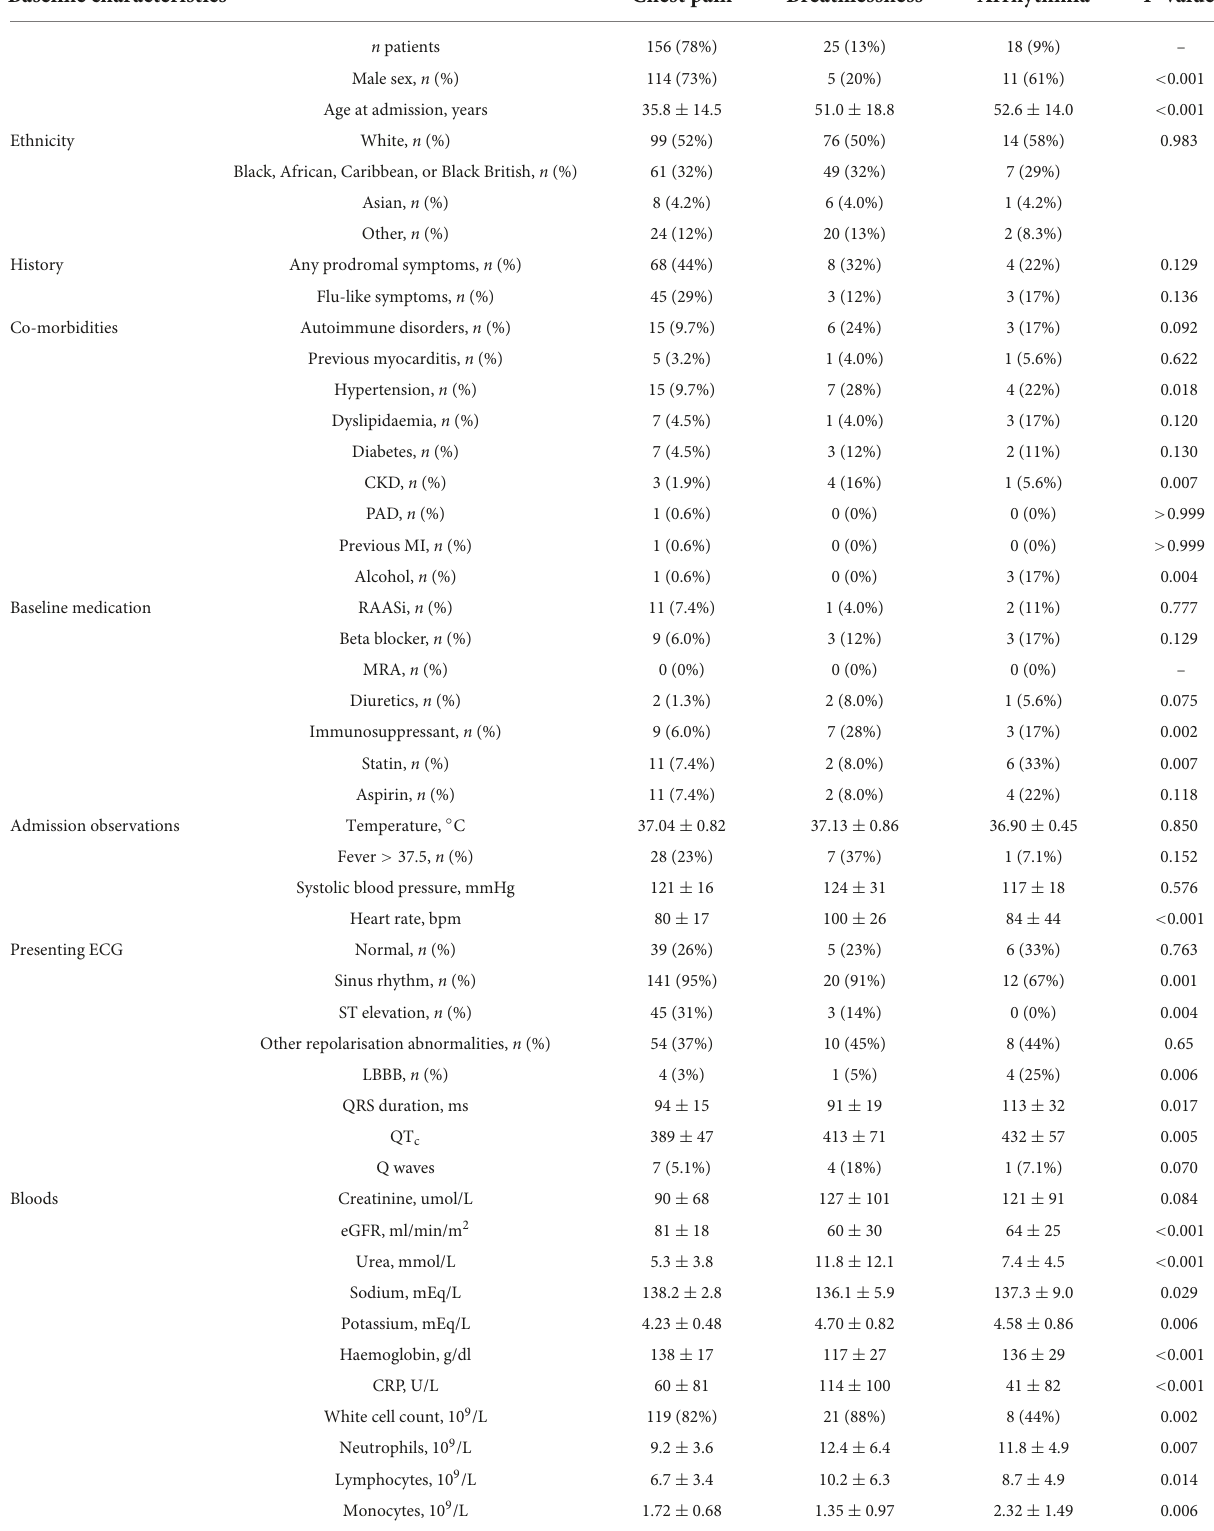
TABLE 2 Characteristics of study patients according to clinical